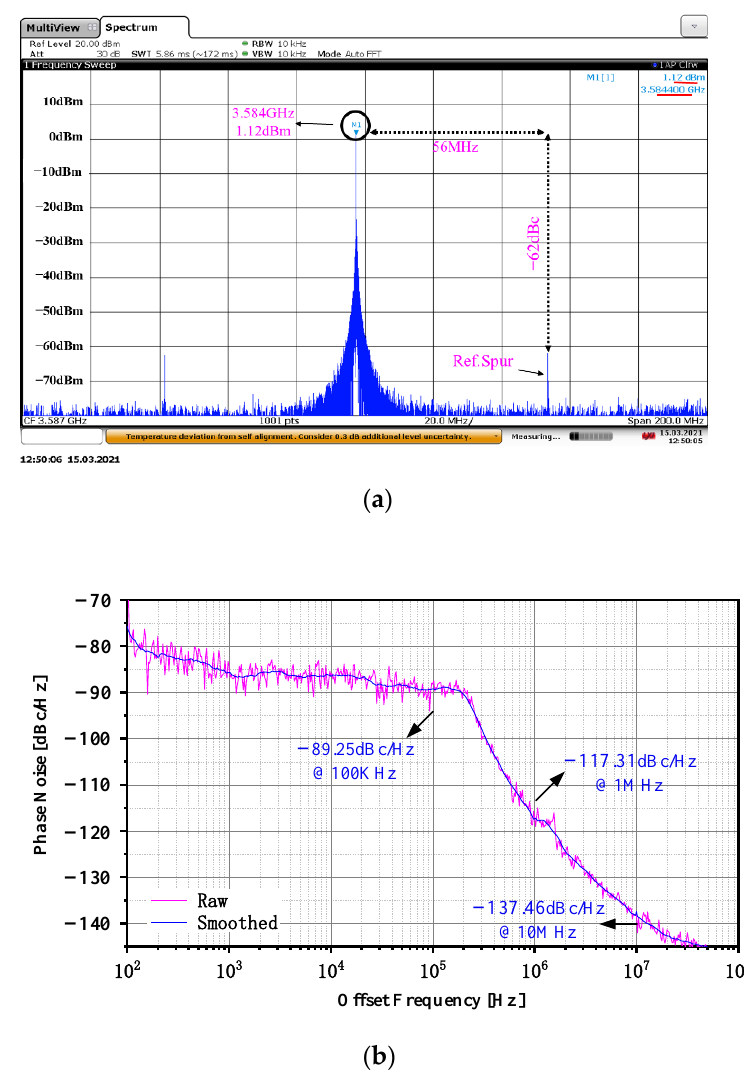
Figure 11. The test results when the output signal is 3.584 GHz: ( a ) the frequency spectrum; ( b ) the phase noise.